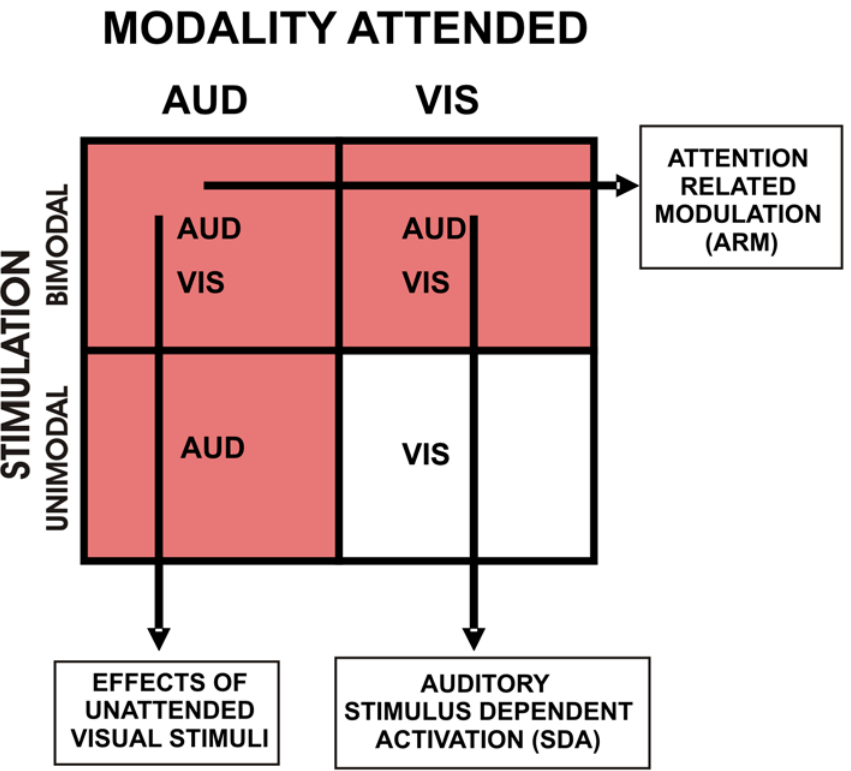
Figure 1. Conditions in the intermodal selective attention experiment. Red blocks show conditions with auditory stimuli. Arrows show the subtractions used for the analysis of sensory responses and attention-related modulations in auditory cortex. SDA=stimulus dependent activation occurring in the absence of auditory attention. ARM=attention-related modulations.